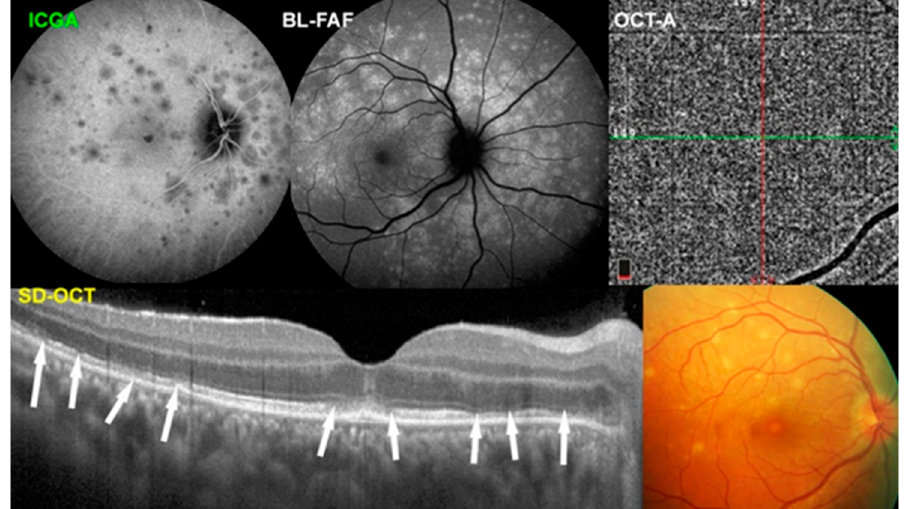
Figure 2. Multimodal imaging in MEWDS. End-choriocapillary non-perfusion is clearly demonstrated on ICGA ( top left ), corresponding to areas delineated by BL-FAF ( top middle ) and to the fundus lesions ( bottom right ). OCT-A does not show any capillary drop-out as it is not able to image low flow end-choriocapillary circulation ( top right ). SD-OCT ( bottom left ) shows loss of photoreceptor outer segments (white arrows) corresponding to ICGA and BL ‐ FAF lesions.